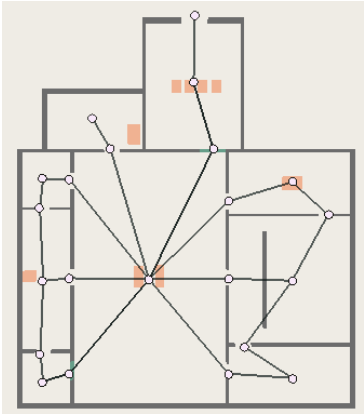
Figure 6: Standard route graph of the